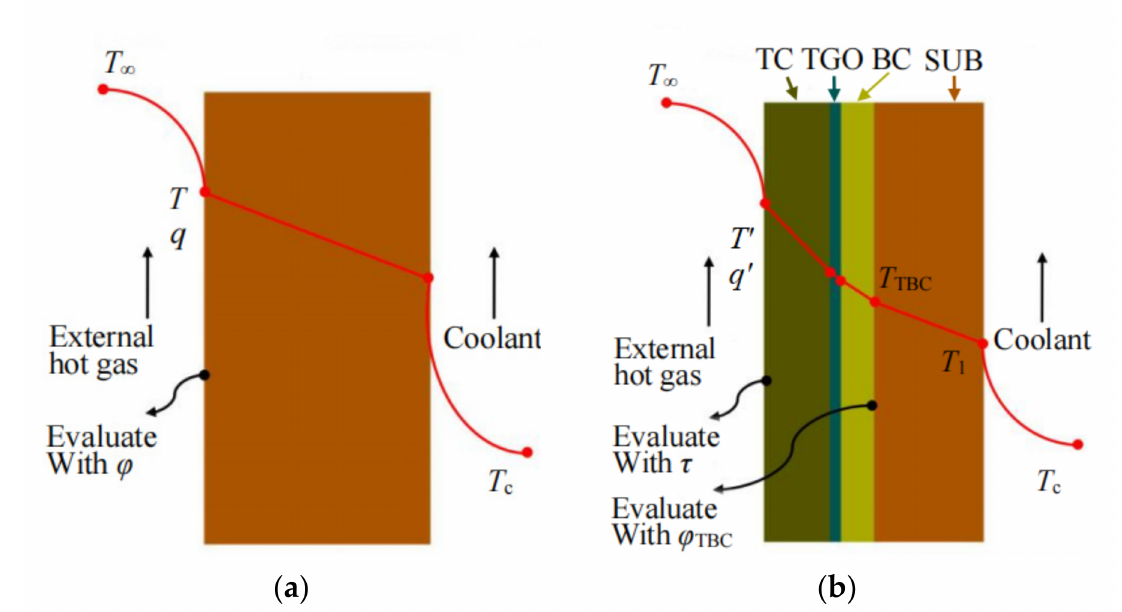
Figure 4. Thermal parameters definition for uncoated vane and coated vane. ( a ) Uncoated vane; ( b ) Coated